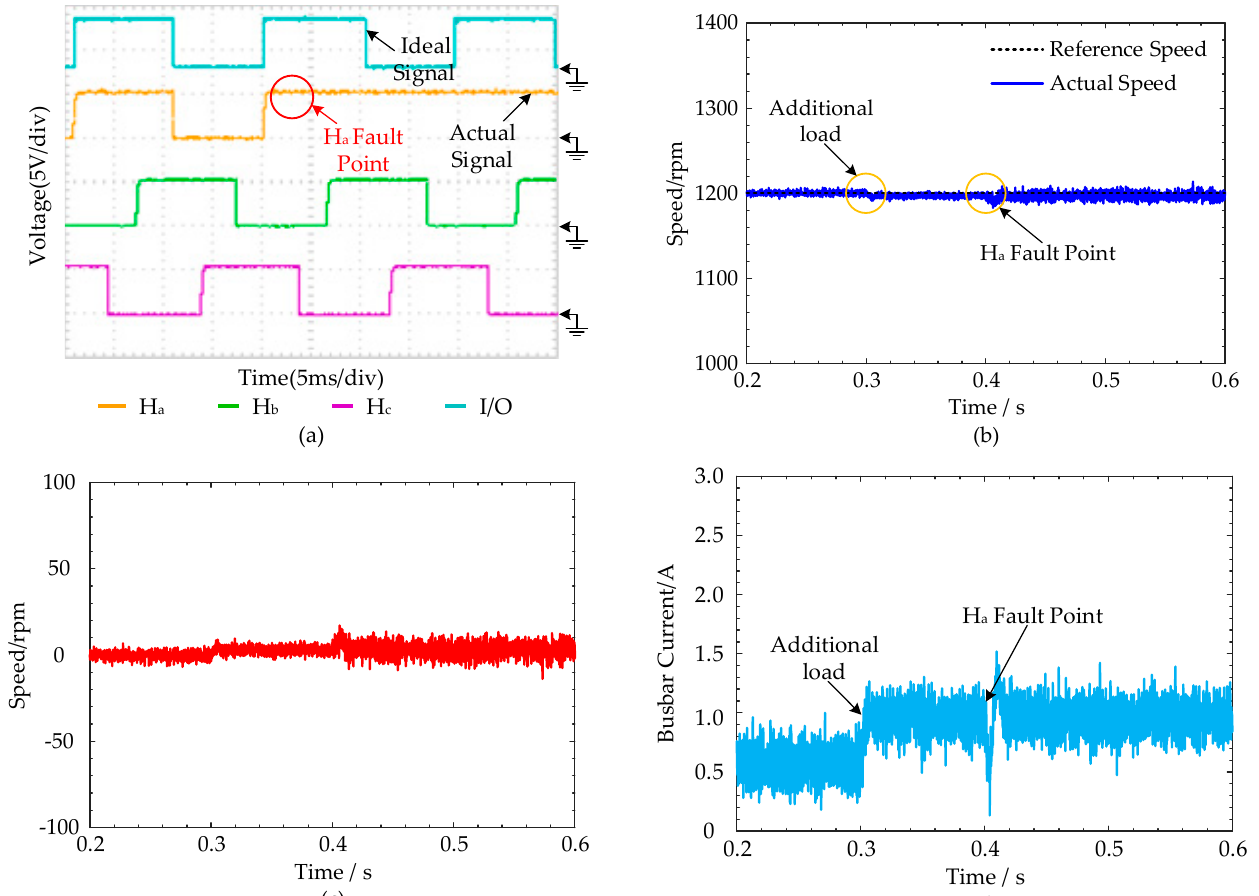
Figure 18. Fault-tolerant control experimental results at load variation: ( a ) the Hall signal curves of the motor; ( b ) the speed curves of the motor; ( c ) the speed error curve at the fault point; ( d ) the busbar current of the motor.